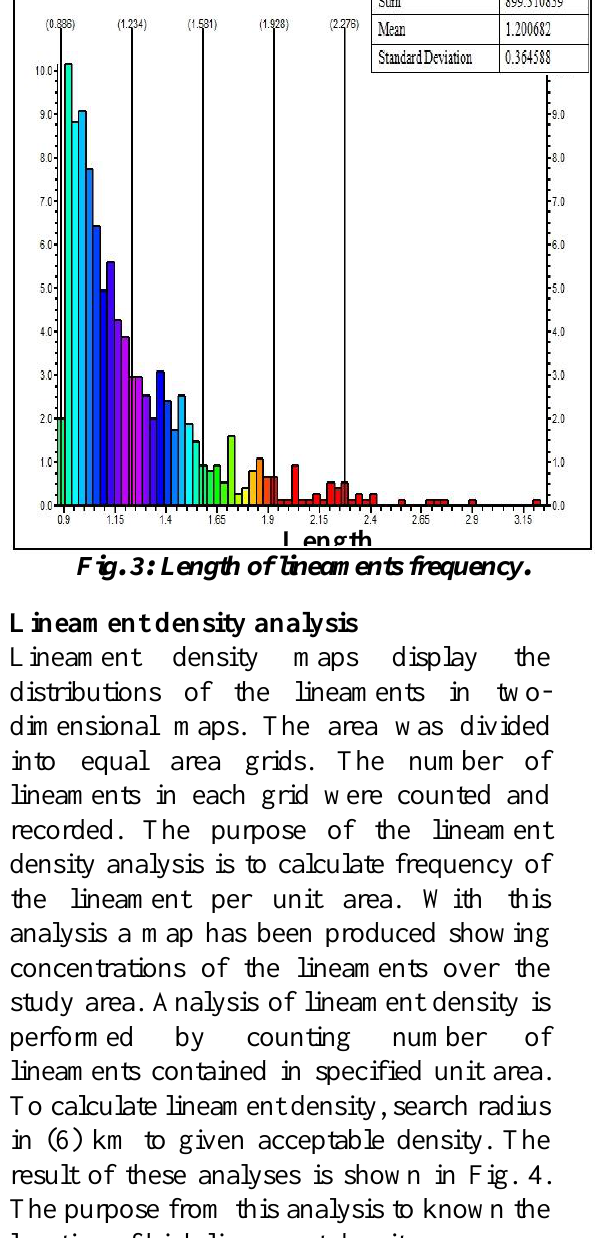
Fig. 2: The automatically extracted lineaments.